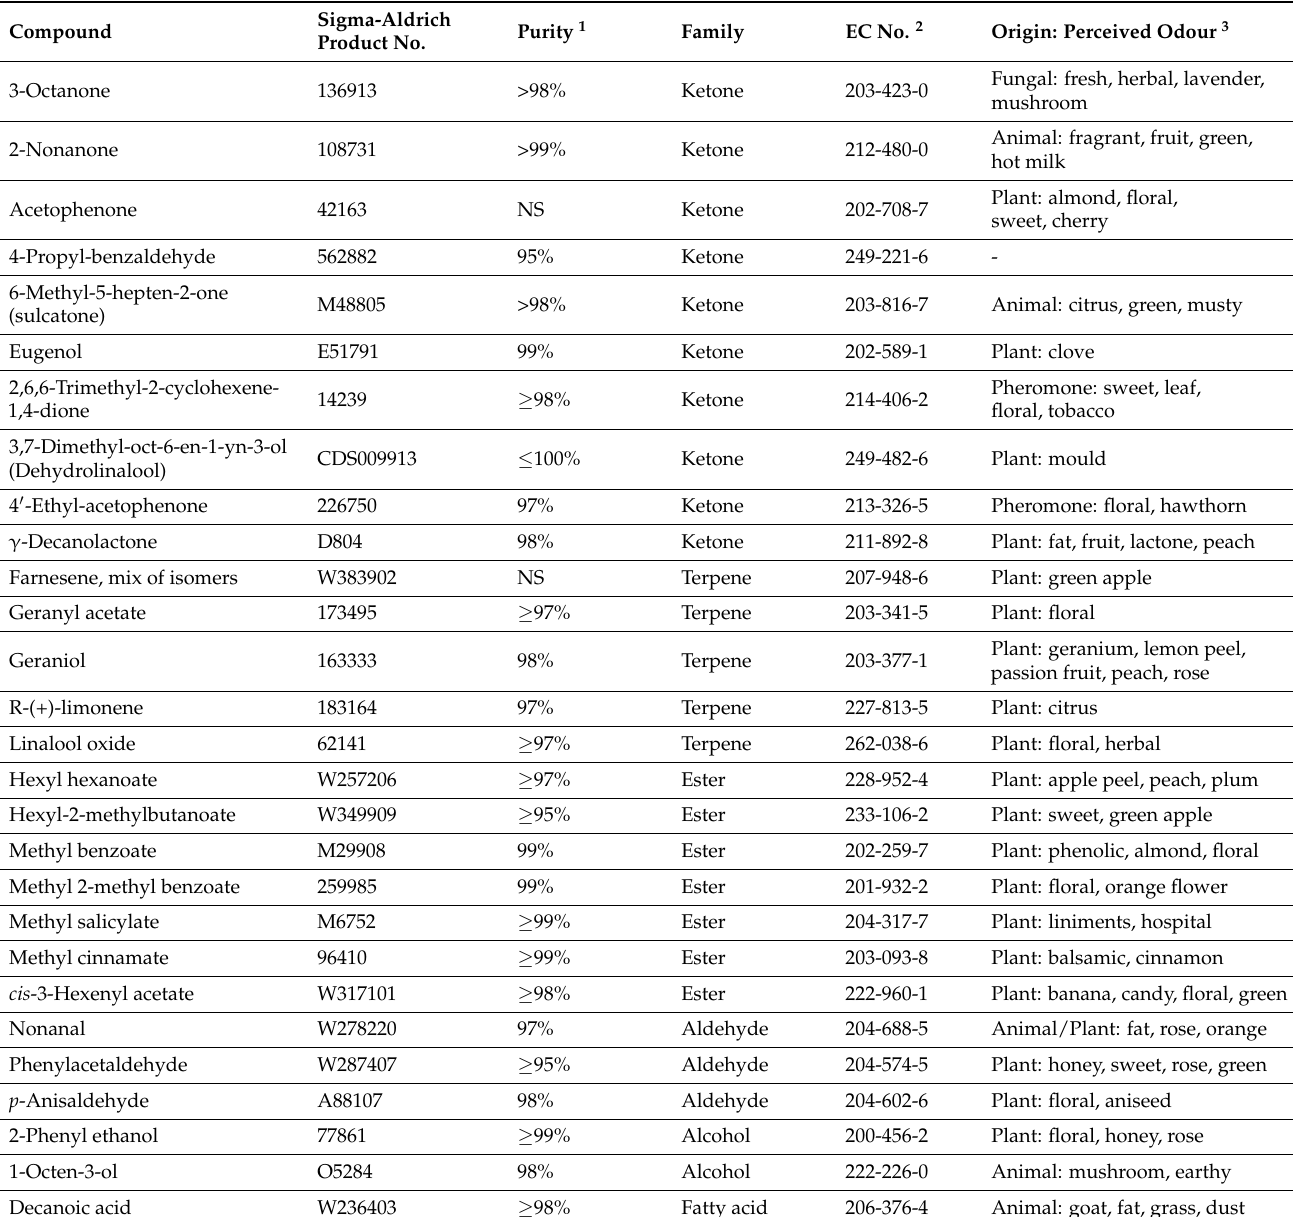
Animal: goat, fat, grass,